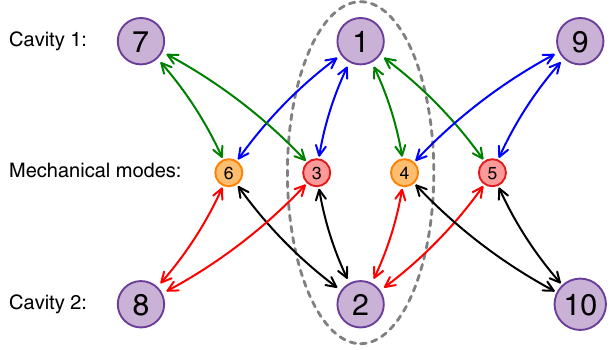
FIG. 5. Ten-mode graph diagram. Like-colored double-sided arrows indicate optomechanical coupling driven by the same microwave drive. Modes 1 – 4 are the four modes in the simplified four-mode model. Modes 5 – 10 are duplicates evaluated off